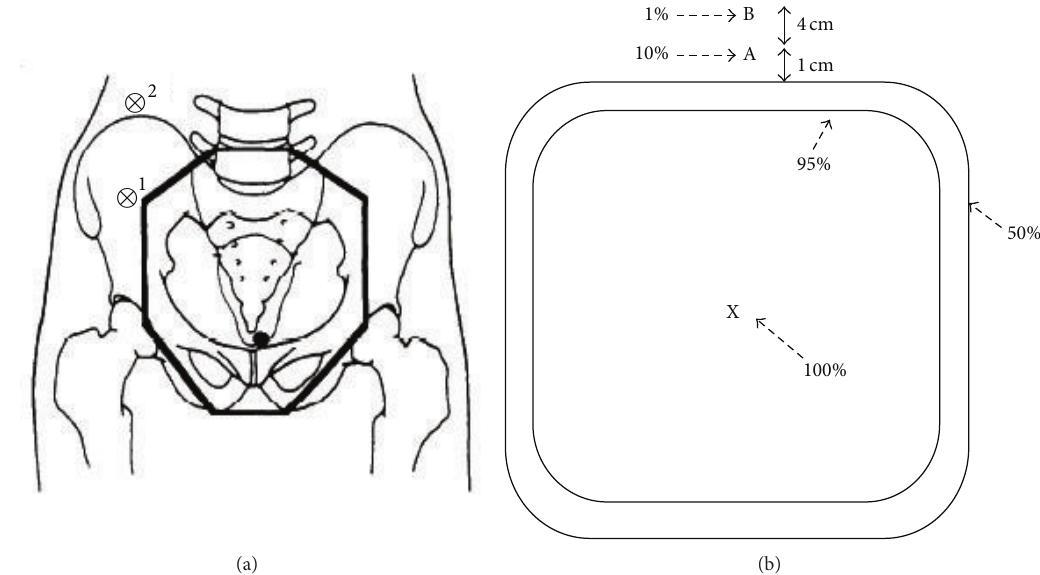
Figure 2: (a) Diagram showing the (AP-PA) whole pelvic radiation therapy field relative to the position of the transposed ovary. Position 1 represents the suboptimal placement of the ovary; position 2 represents the optimal placement of the ovary in terms of maintaining ovarian function. (b) Diagram of a dose distribution. The dose at point A is 10% of the dose at the center of the field (point X, 100%). The dose at point B is 1% of the dose at point X. Therefore, if the prescribed dose was 45 Gy, the dose is 4.5 Gy at point A and 0.45 Gy at point B [13,